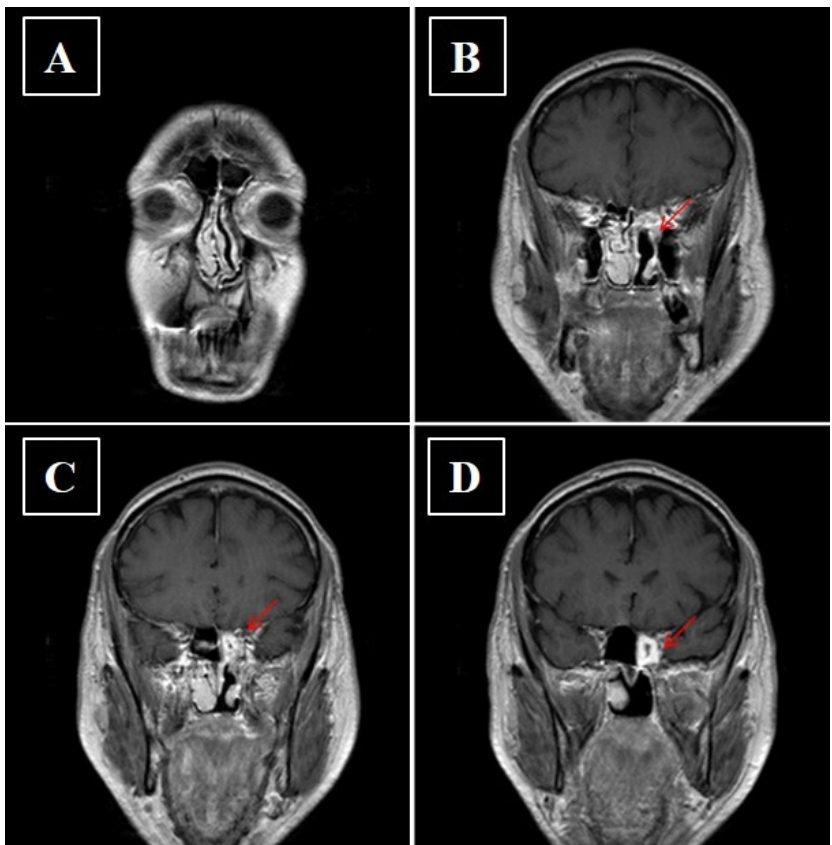
Figure 8. ( A , B , C , D ) Axial contrast enhanced fat-suppressed T1-weighted image showing